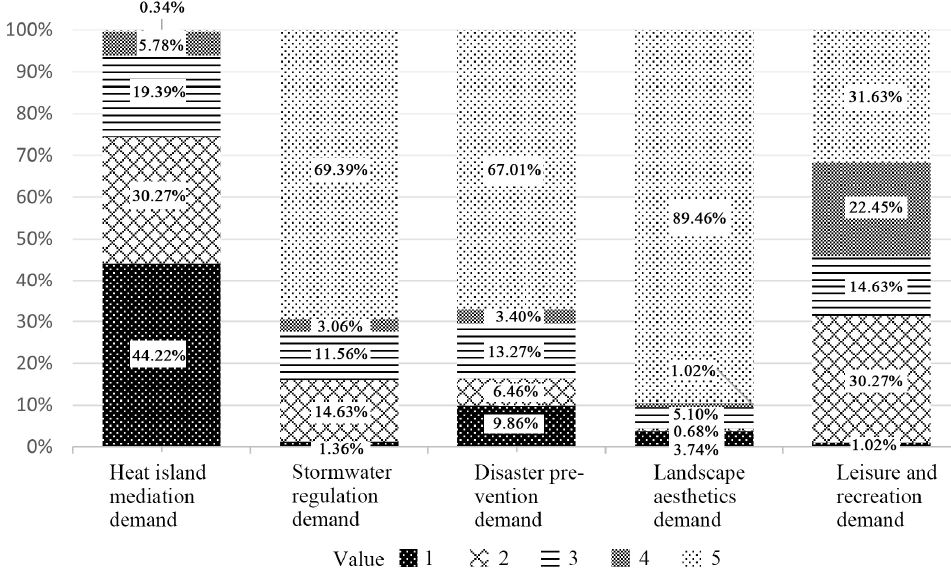
Figure 6. Percentages of urban demand values of brownfields.